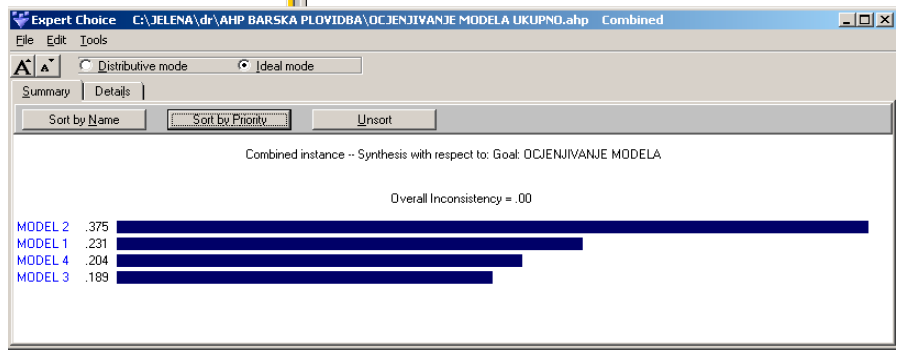
Figure 9. Final results of ranking of the models.